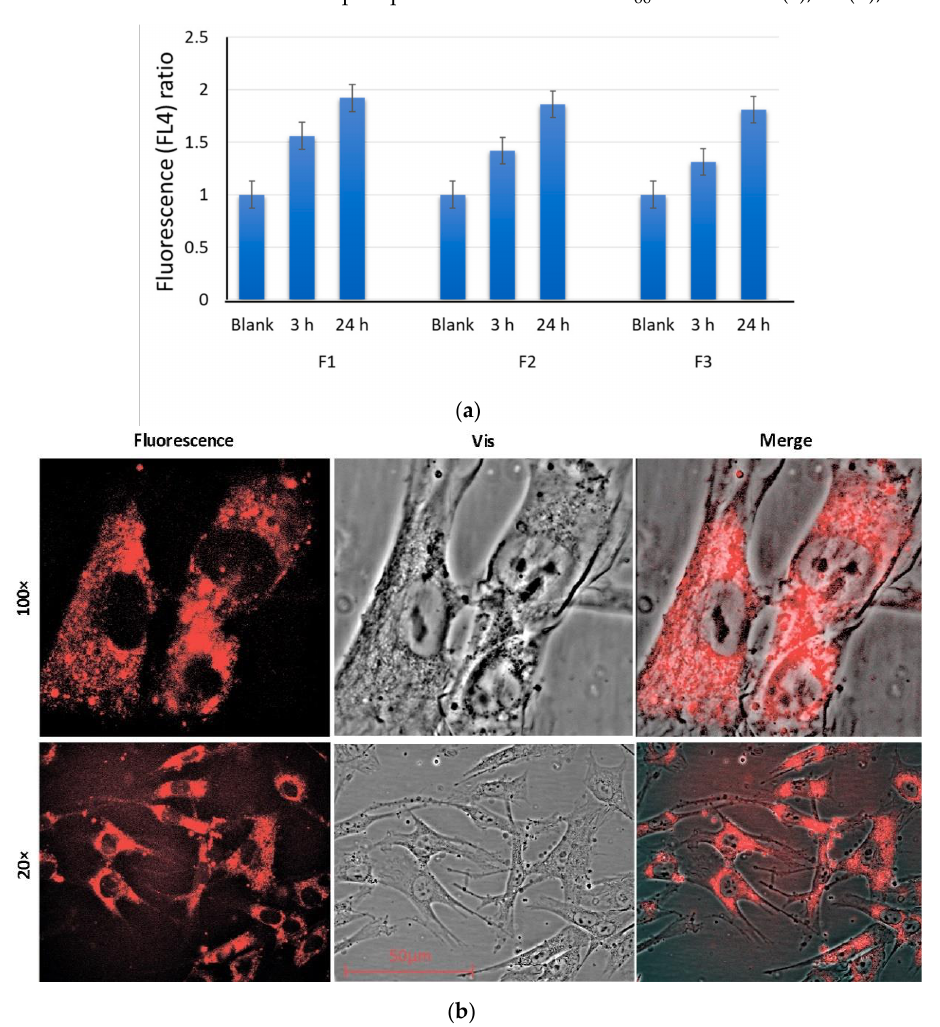
Figure 3. Permeation of F1 (170 µM), F2 (195 µM), and F3 (290 µM) into MSCs after 3 h and 24 h of incubation assessed with flow cytometry. The fluorescence (FL4) is the mean value for three experiments related to the blank ( a ) and distribution of F2 (195 µM) in the cells after 24 h of incubation detected with fluorescence microscopy (20× and 100×) ( b ).